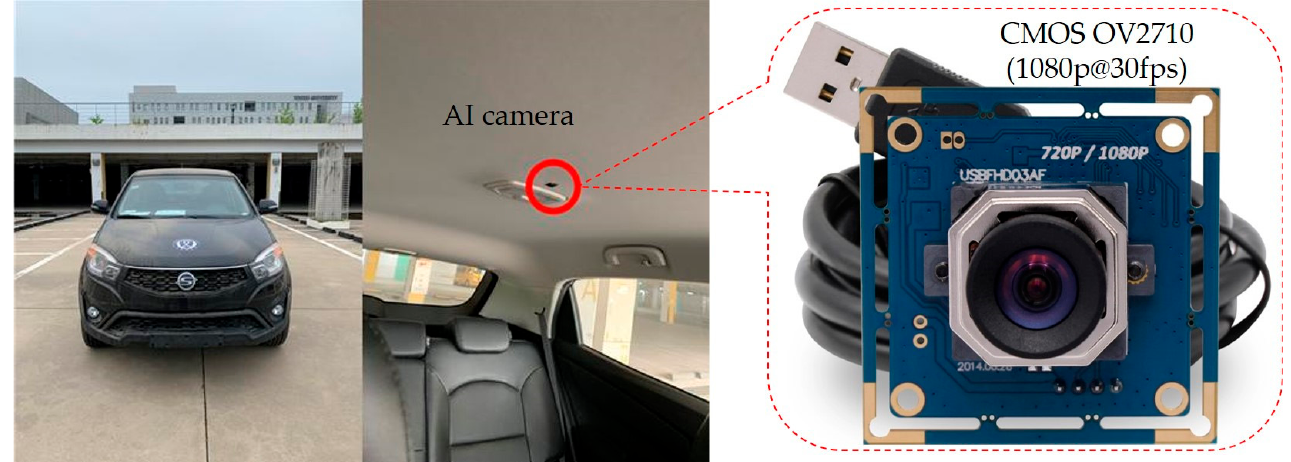
Figure 4. A four-seater vehicle is used in the development of DB. The left image depicts the AV used for DB collection, and the AI camera is discerned on the right side of the image.